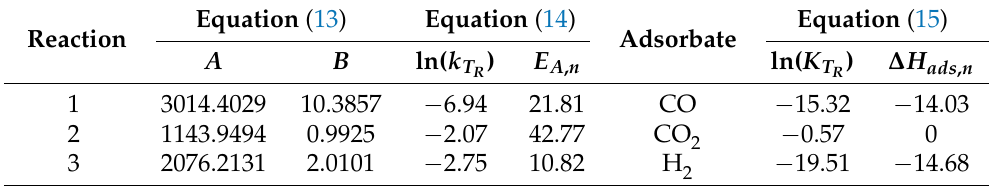
Table 1. Model-specific parameters for the lumped model